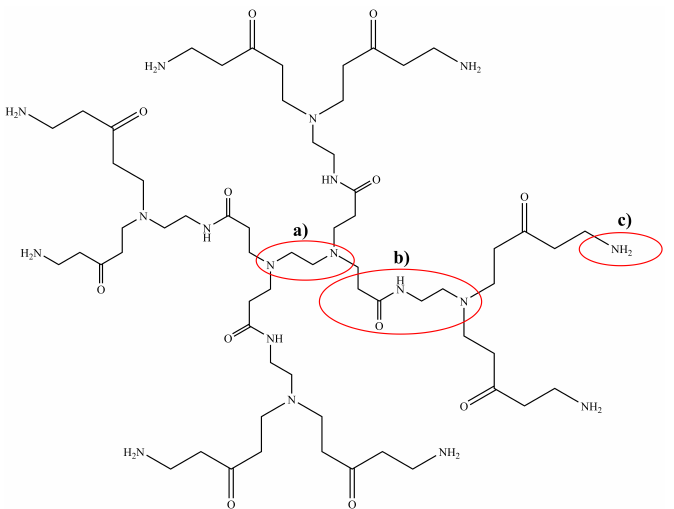
Figure 8. Chemical structure of a 1st generation poly(amidoamine) (PAMAM) dendrimer with ( a ) an ethylene diamine core, ( b ) amidoamine dendrons and ( c ) an amino terminal group. There are a number of different terminal groups that PAMAM dendrimers are available in, making them very versatile for drug-delivery